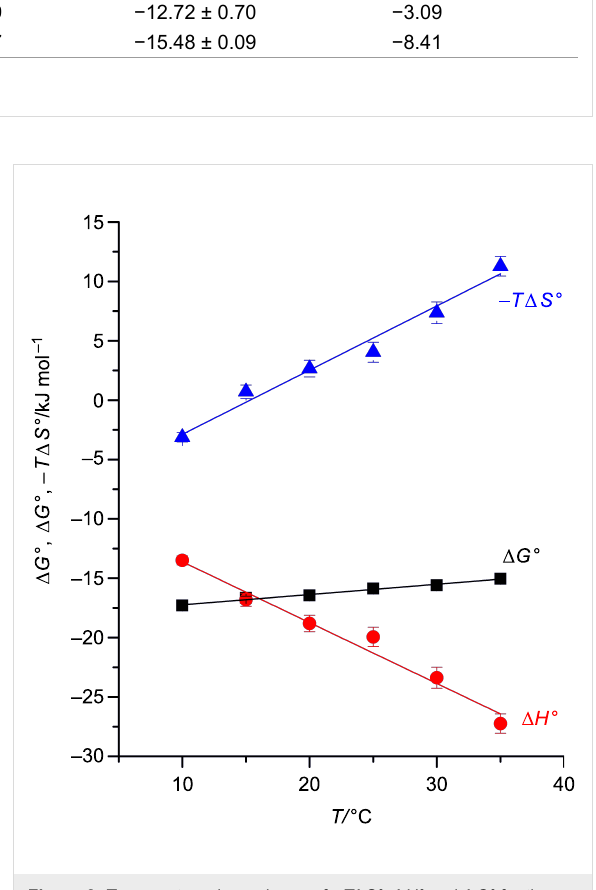
Figure 2: Temperature dependence of − T Δ S° , Δ H° and Δ G° for the inclusion of 1-adamantane carboxylate in heptakis-2,3,6-tri- O -methyl- β -CD ( 3 ) measured by ITC